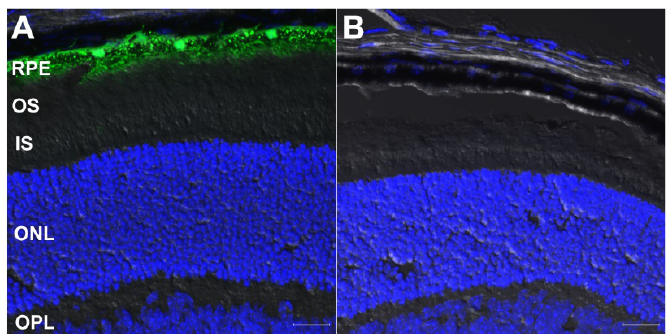
Figure 2. Cre recombinase-dependent ZsGreen expression (green) in mouse retina. ( A ) Retina from a postnatal (PN) one-month old CreRPE × ZsGreen reporter mouse, demonstrating ZsGreen expression specifically in retinal pigment epithelium (RPE) cells. ( B ) Retina from an age-matched, wild type (WT) mouse retina, demonstrating lack of ZsGreen expression. Nuclei counterstained with DAPI (blue). Abbreviations: IS, photoreceptor inner segment layer; OS, photoreceptor outer segment layer; ONL, outer nuclear layer; OPL, outer plexiform layer. Scale bars (both panels): 20 μm.